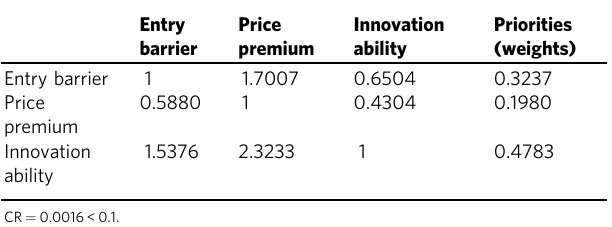
Table 9 Aggregated pairwise comparison matrix of sub- factors within main factor “ competitor ” .